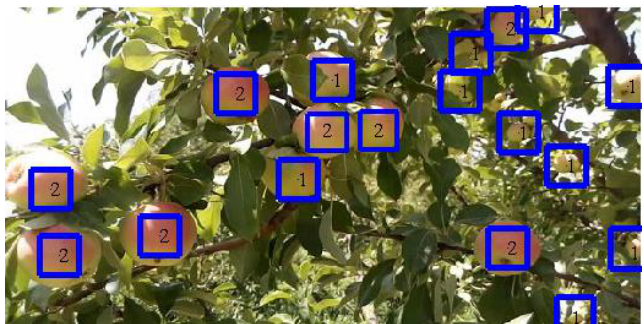
Figure 5. A sample video frame after application of the proposed apple ripening classification. The number corresponds to the ripening label (1. unripe; 2. half-ripe). A sample video with more results is available at https://youtu.be/A3ROtqRy9os